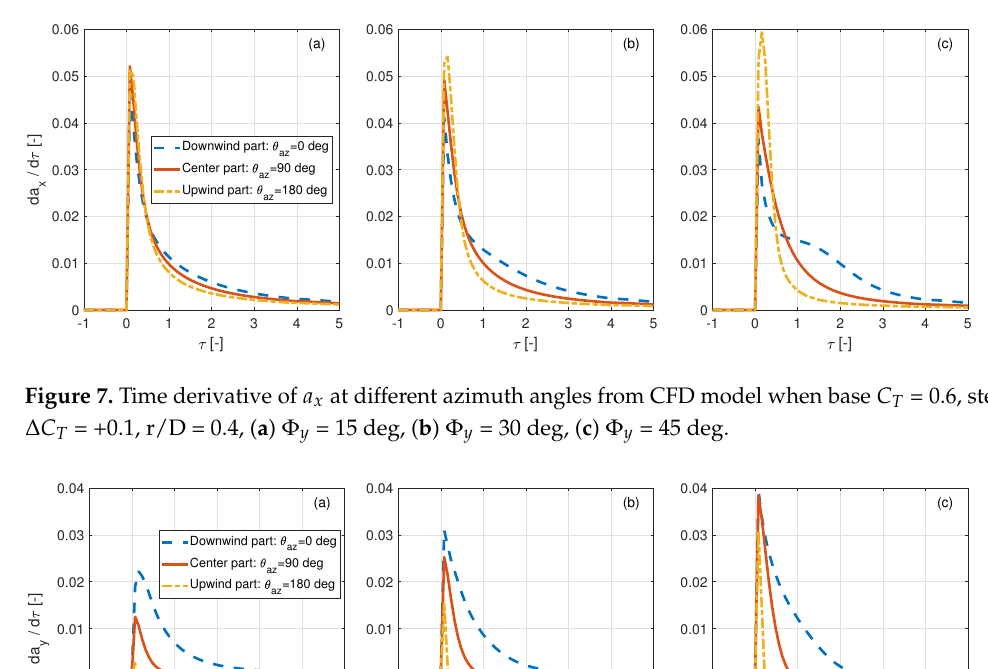
Figure 8. Time derivative of a y at different azimuth angles from CFD model when base C T = 0.6, step ∆ C T = +0.1, r/D = 0.4, ( a )